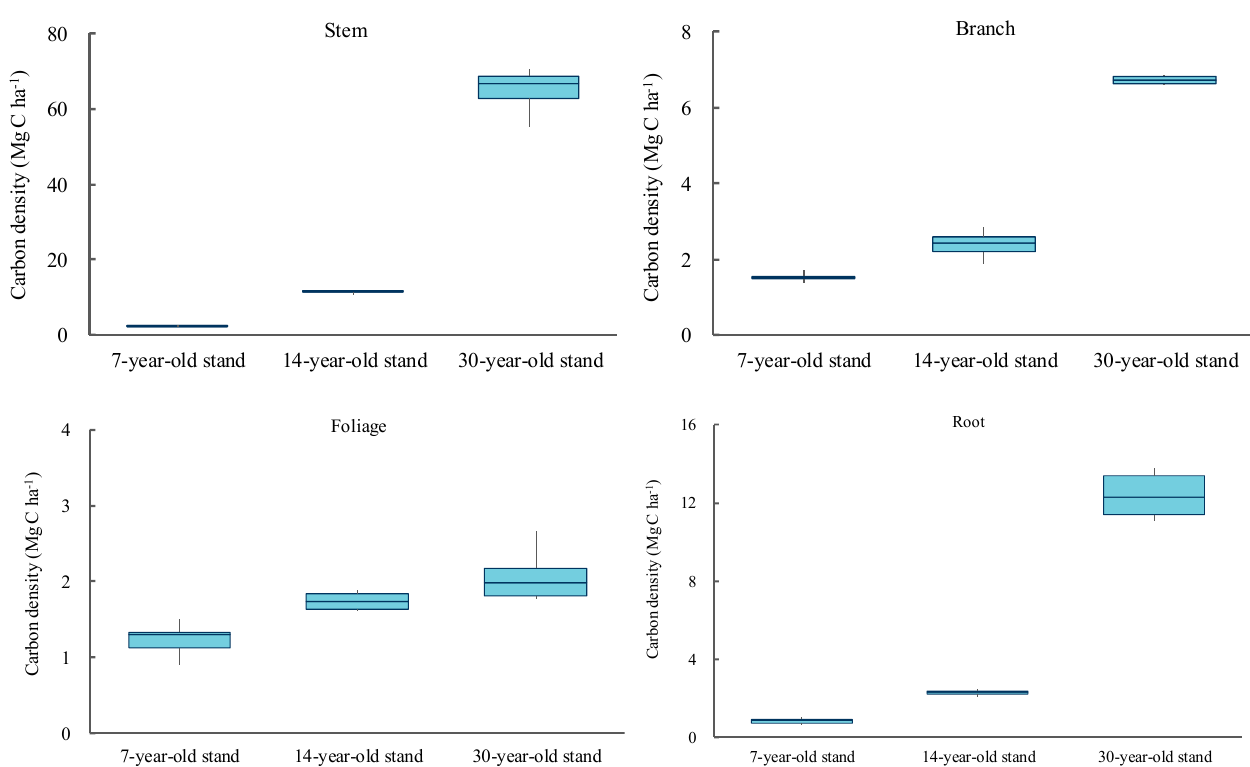
Forests 2021 , 12 , 1342 Figure 3. Carbon densities in various components of trees across a chronosequence of Masson pine plantations.